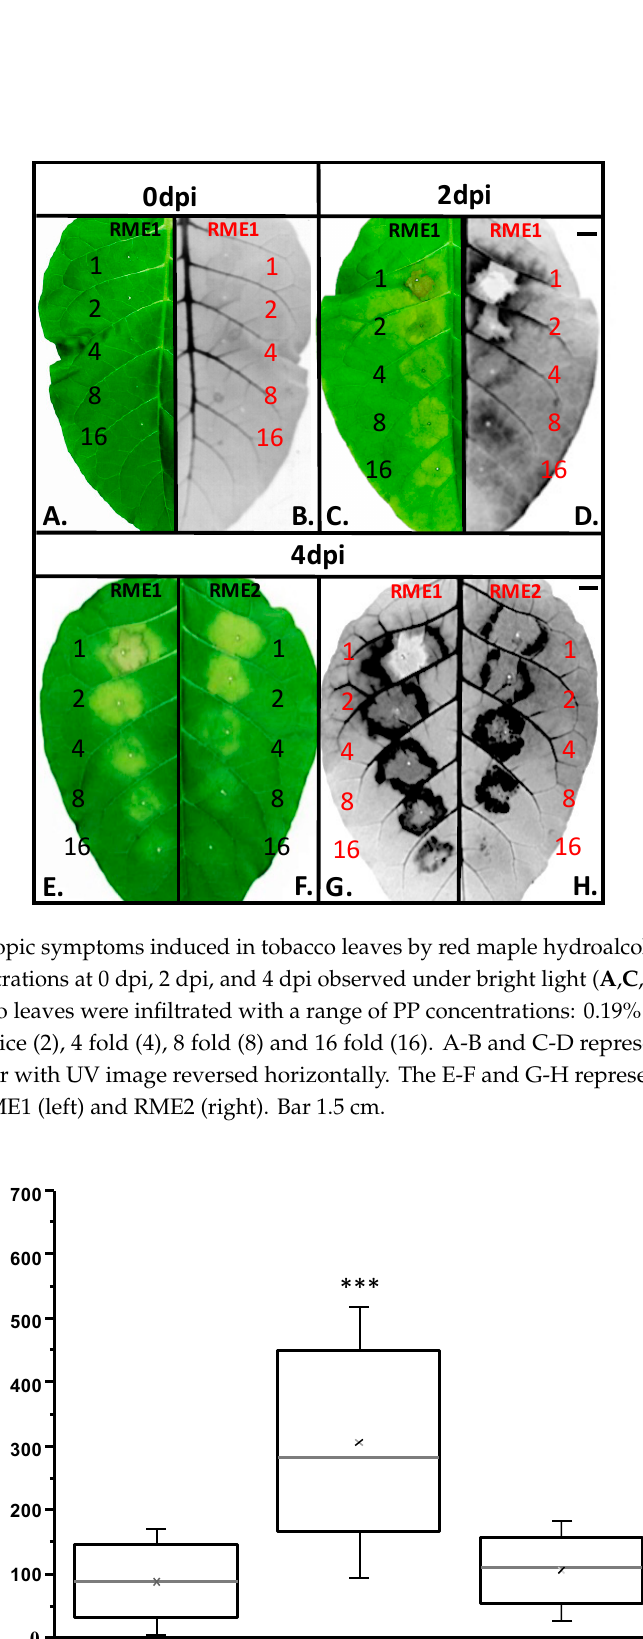
Figure 2. Scopoletin accumulation in tobacco leaves after infiltration of 0.095% polyphenol (PP) concentration of RME1 before (RME1) and after alkaline hydrolysis (h-RME1). Leaves were infiltrated with RME1 or h-RME1 on 20 distinct areas and scopoletin quantification was measured at 4 dpi by HPLC. Each experiment was performed in triplicate (3 leaves per plant, 3 plants). Asterisks indicate significant differences compared with the control (***) p < 0.001.